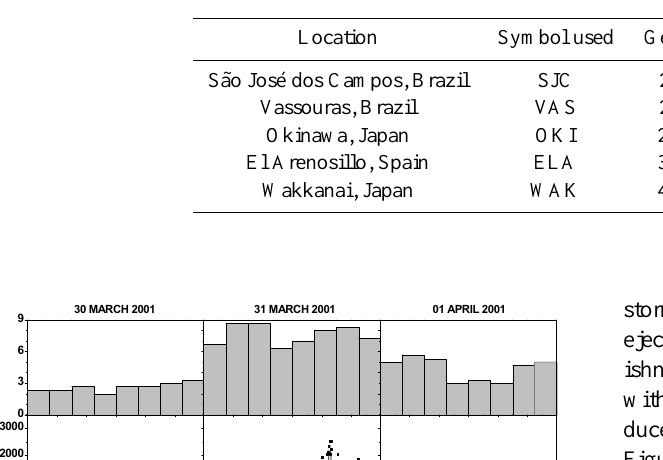
Table 1. Details of the observing sites.